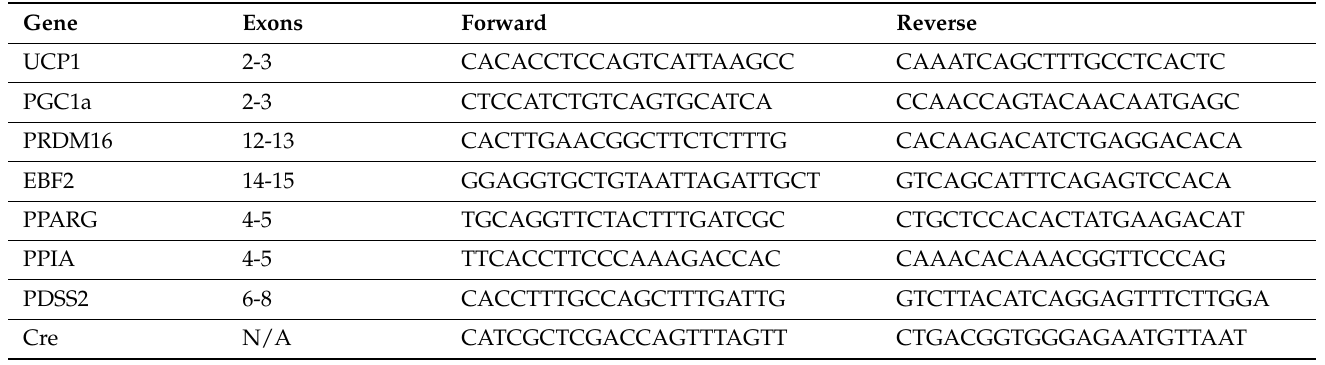
Table A1. rt-PCR primer sequences.